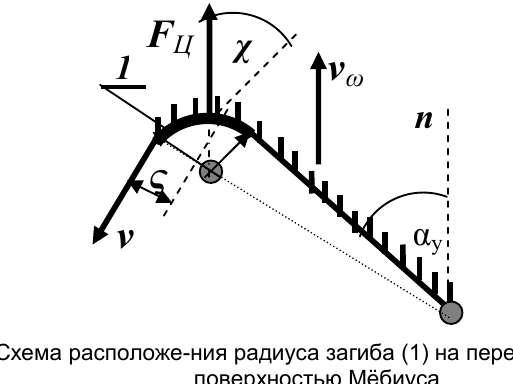
Figure 4 – Schematic presentation of the position of the curve radius on the Mobius propeller front